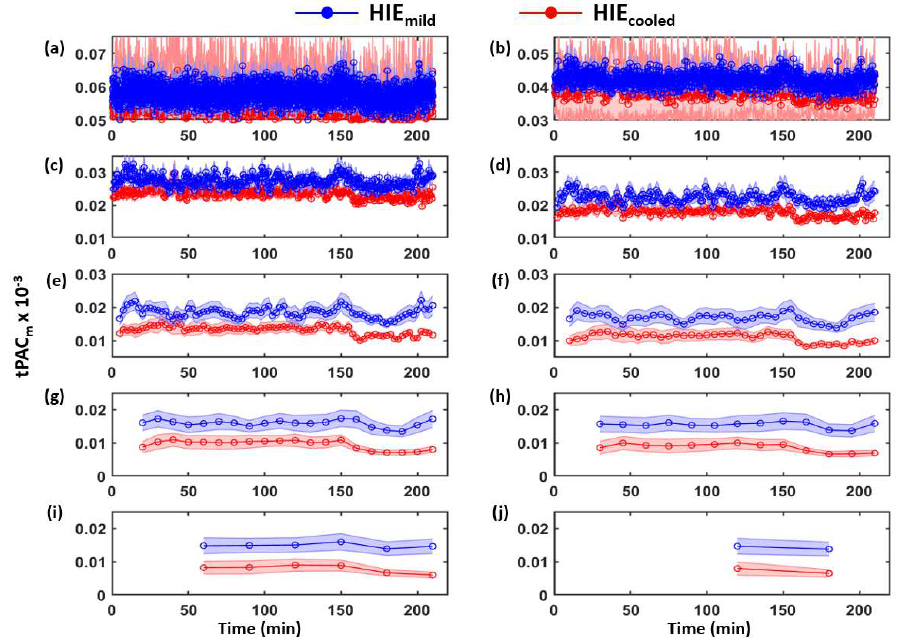
Figure A4. tPAC m indexes at Cz from HIE mild (blue) and HIE cooled (red) under ( a ) 10 s; ( b ) 20 s; ( c ) 1 min; ( d ) 2 min; ( e ) 5 min; ( f ) 10 min; ( g ) 20 min; ( h ) 30 min; ( i ) 60 min; ( j ) 120 min window sizes. Each point denotes the cross-neonate average of tPAC m for the group at different time in the 6 HOL. The shaded error bar indicates the standard error of the mean. t = 0 indicates the start of EEG recording.